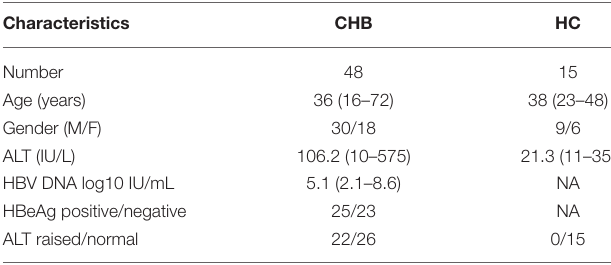
TABLE 2 | Clinical characteristics of CHB patients and